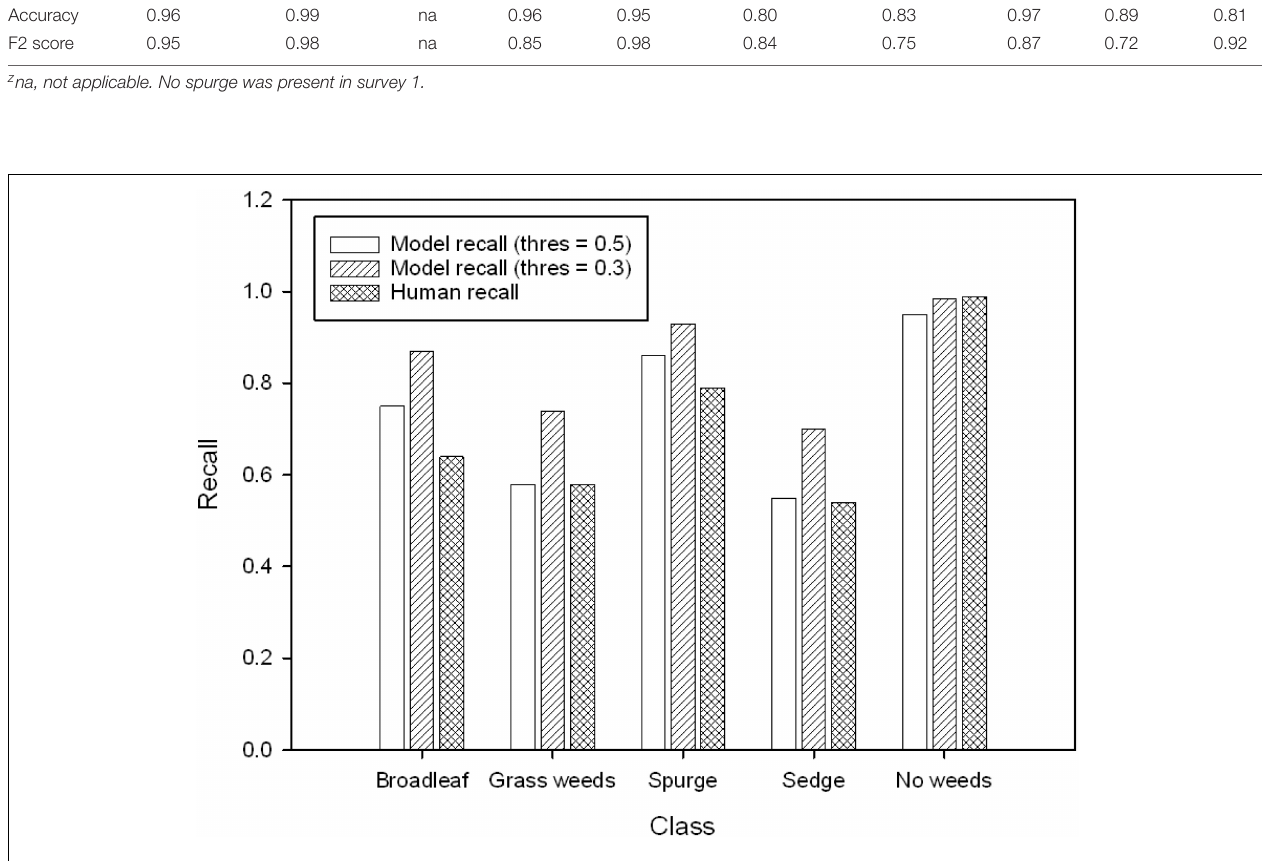
Frontiers in Plant Science |